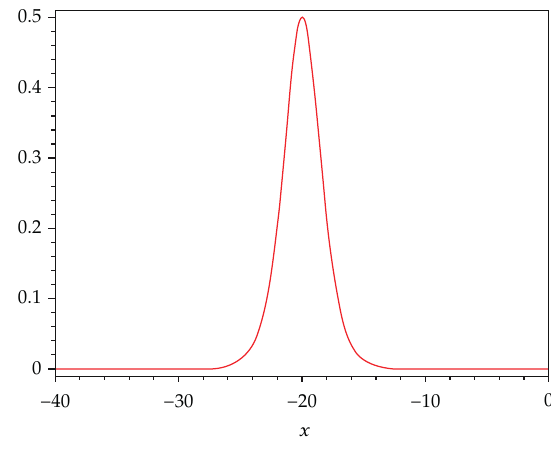
Figure 1: Bell-like solitary